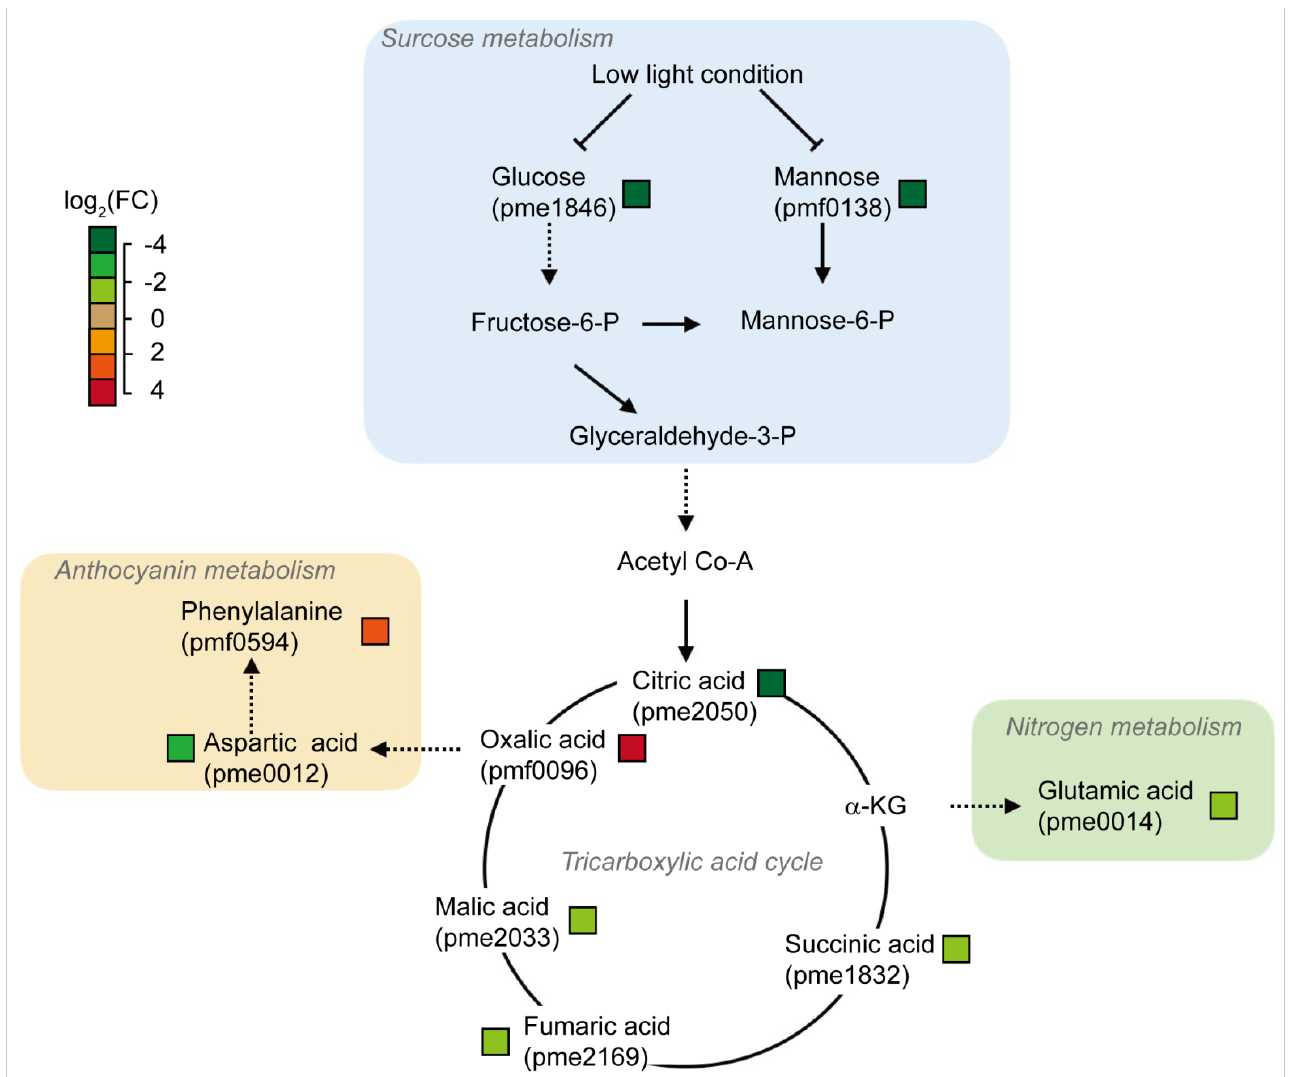
Figure 7. Metabolic pathways of sucrose degradation and tricarboxylic acid cycle in response to low light in XH1 cai-tai seedlings. FC: fold change of the abundance of each metabolite determined in XH1 in low light versus high light.